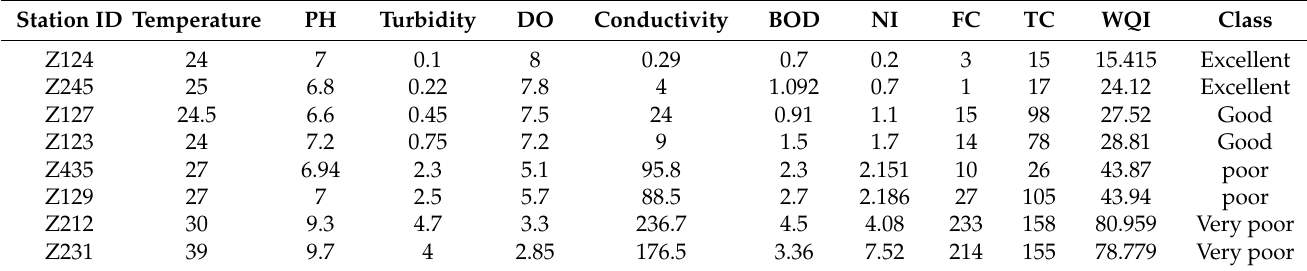
Table 6. Sample from the used